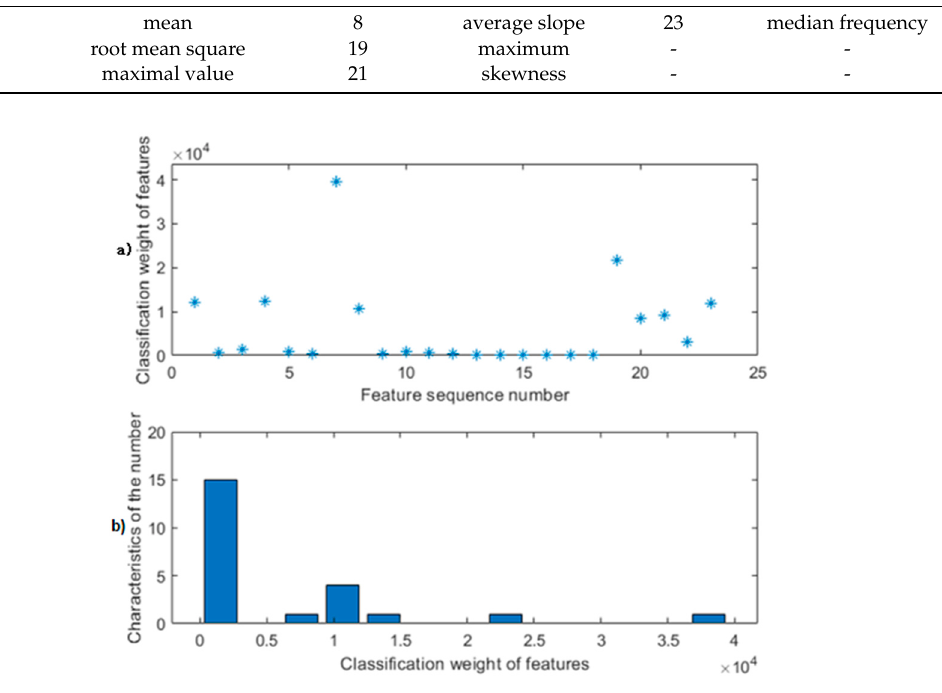
Figure 4. Feature classification weight diagram before threshold setting: ( a ) Upper submap: Feature weight value map; ( b ) Lower submap: Weight value frequency chart.